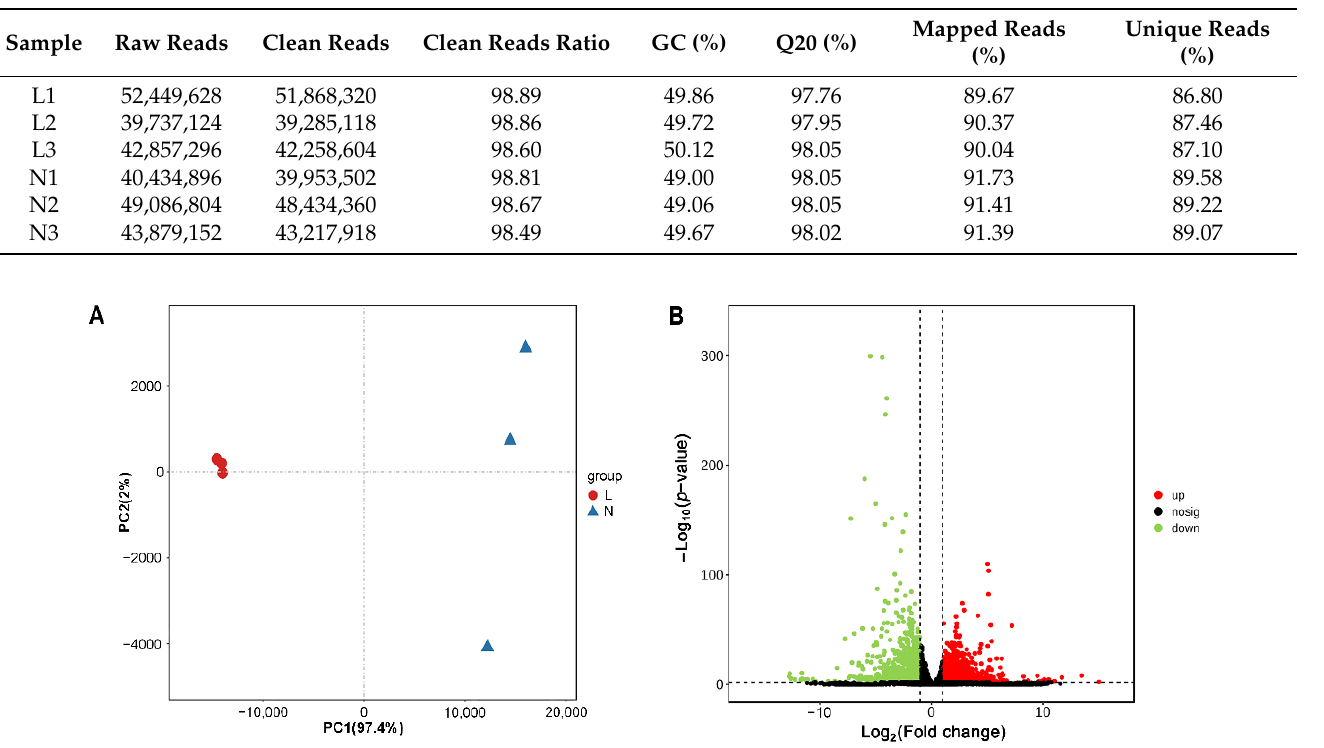
Figure 2. Differential gene expression analysis between L and N groups determined by RNA-seq. ( A ) Principal component analysis (PCA) of differentially expressed (DE) mRNAs. ( B ) Volcano plot of DE mRNAs in jenny mammary glands between L and N groups. The upregulated and downregulated DE mRNAs are indicated by red and green dots, respectively, while the DE mRNAs with no significant difference in the two groups are indicated by black dots. L, lactating mammary glands of jennies; N, nonlactating mammary glands of jennies.